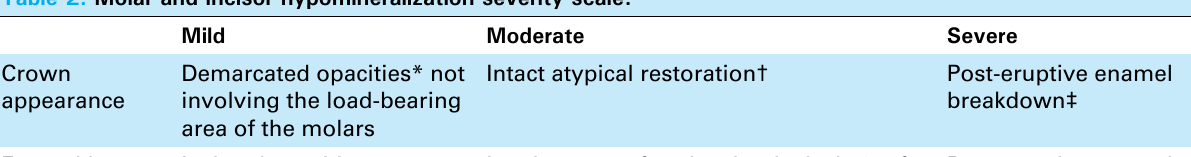
Table 2. Molar and incisor hypomineralization severity scale. 21